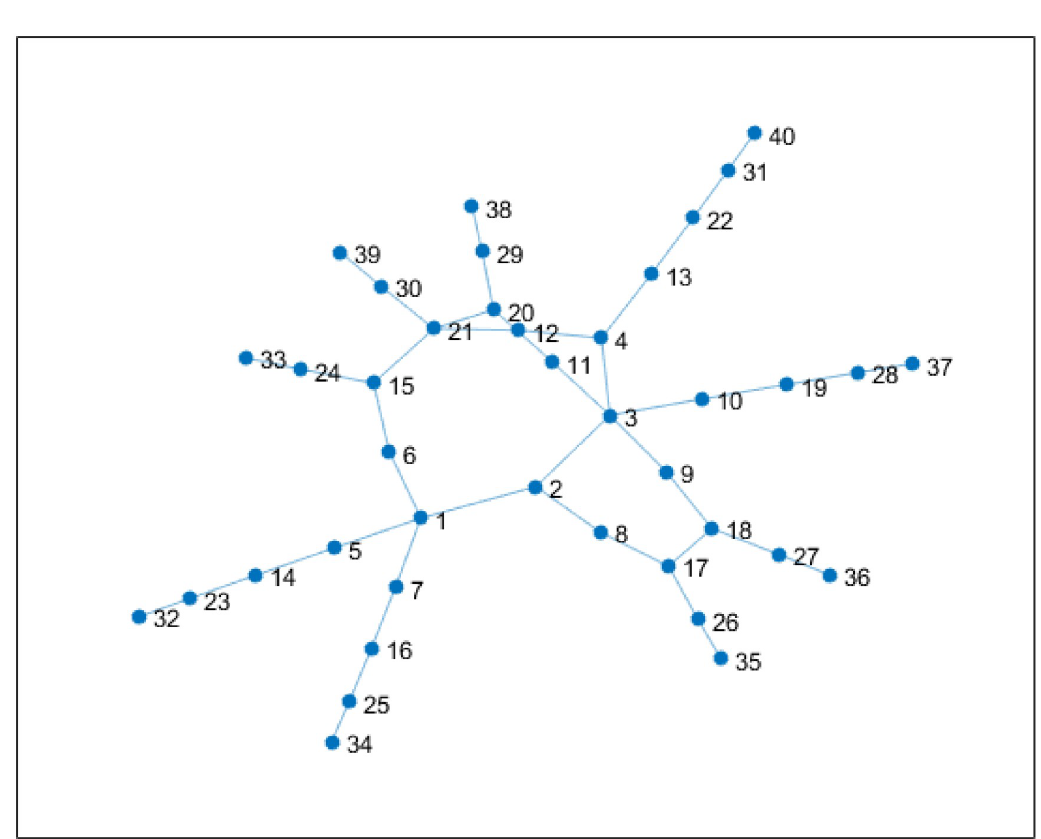
Fig 4. Synthetic network with 40